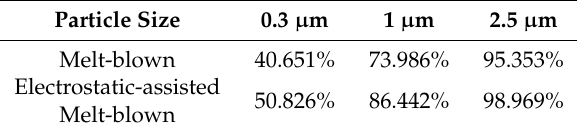
Figure S1. SEM graphs of the PP fiber prepared by melt blown under different melt temperatures: 220 ◦ C (a), 240 ◦ C (b), 260 ◦ C (c), 280 ◦ C (d), and 300 ◦ C (e). The fiber diameter analysis of these fabrics is shown in (f). Figure S2. SEM graphs of the PP fiber prepared by melt blown under different air temperatures: 220 ◦ C (a), 240 ◦ C (b), 260 ◦ C (c), 280 ◦ C (d), and 300 ◦ C (e). The fiber diameter analysis of these fabrics is shown in (f). Figure